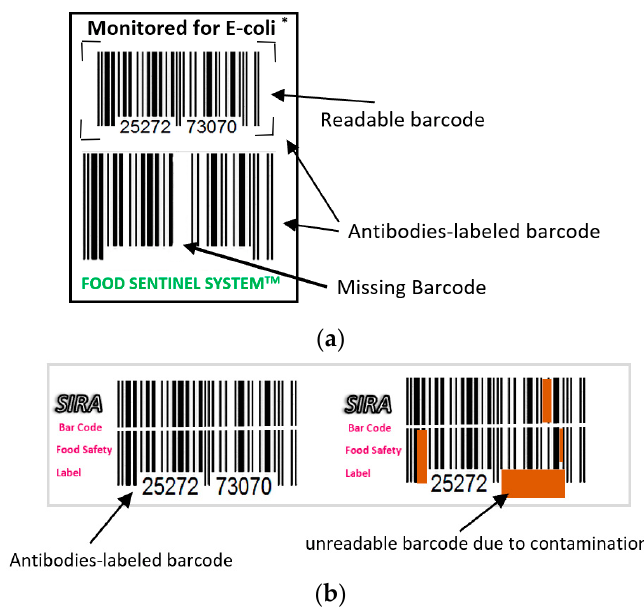
Figure 17. ( a ) Form of food sentinel system. ( b ) Another form of food sentinel system.